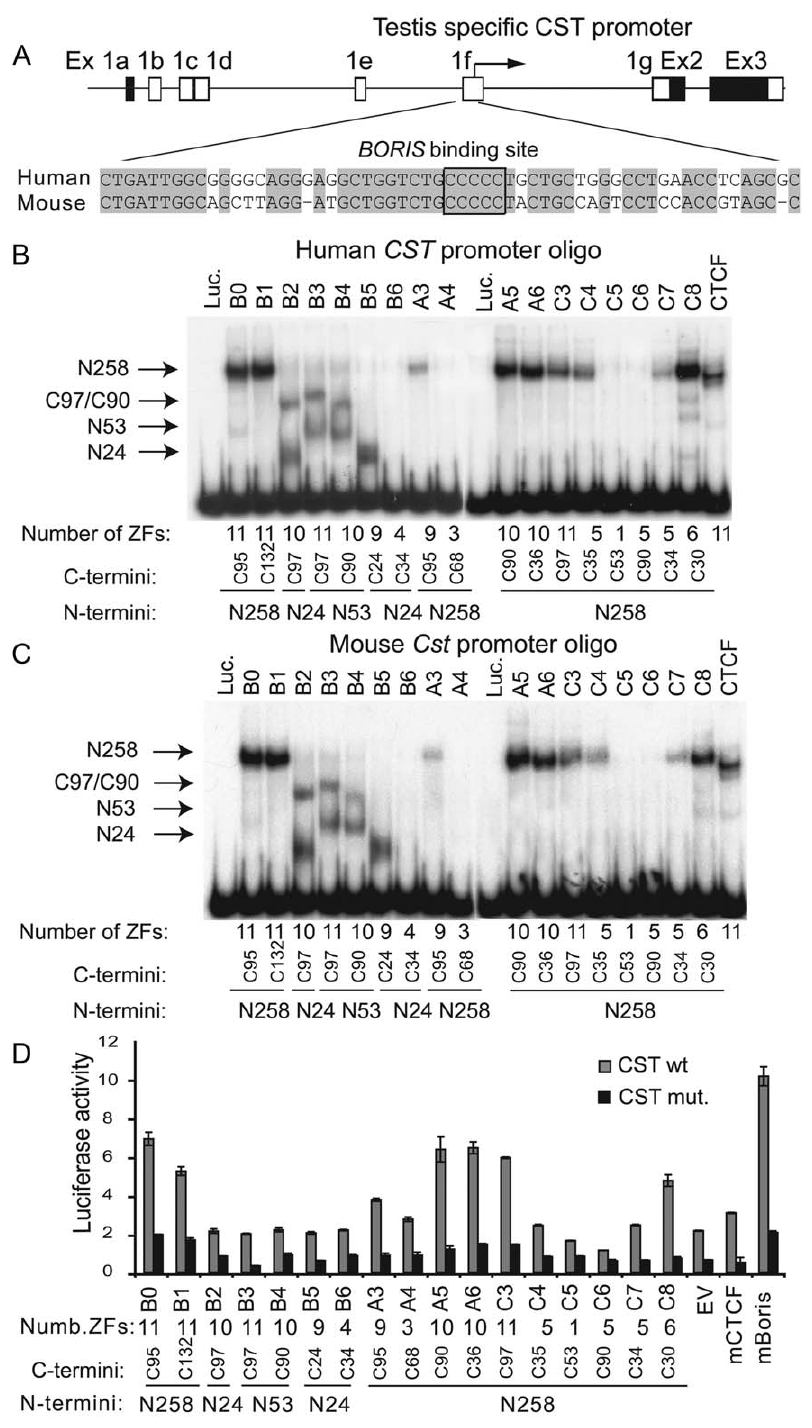
Figure 8. BORIS isoforms bind and activate the transcription of conserved human and mouse CST testis-specific promoter regions. ( A ) Schematic representation of multiple mouse CST promoters, where exon 1f s has been shown to be testis specific [48] and the BORIS binding site has been mapped to the testis-specific CST promoter [9]. The alignment of human and mouse BORIS binding site in CST promoter is shown at the bottom. The 5 cytosines boxedinthealignment arecontactnucleotides for BORISproteinas itwas determinedbymethylationinterferenceassays [9]. Nucleotidesthatare 100% identical to the human nucleotide sequence are shaded in grey. Dashes indicate insertions or deletions. ( B ) and ( C ) Most BORIS isoforms bind to the human and mousetestis-specific CST promoter in EMSA. The number of ZFsand utilizationof alternative N-and C-termini for eachBORIS isoform are shown at the bottom of gel. Theband shifts specific for particular N- and C-terminiare indicated by arrows. Luciferase and CTCF wereused as negative and positive controls, respectively. ( D ) The mouse CST promoter is transcriptionally activated by BORIS isoforms in HEK293T cells. HEK293T cells were either co- transfected with mouse Boris, mouse Ctcf, empty pCI vector (EV) or the human BORIS isoform constructs, as well as with pGL-3 containing 359 bp of wild type or mutant CST promoter. Luciferase assays were done 48 h after transfections. All luciferase activities were normalized for transfection efficiency by measuring the Renilla luciferase activity from the co-transfected pRL-TK vector. Error bars are standard deviations. doi:10.1371/journal.pone.0013872.g008 PLoS ONE |